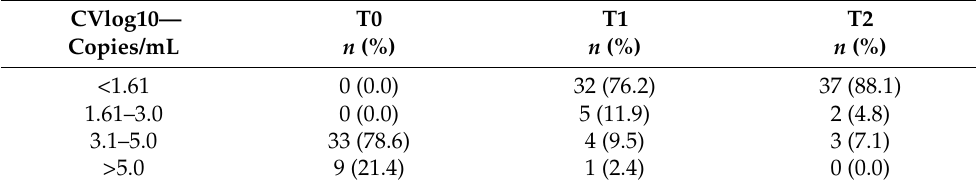
Table 3. Viral load levels of PLHIV between the periods evaluated.